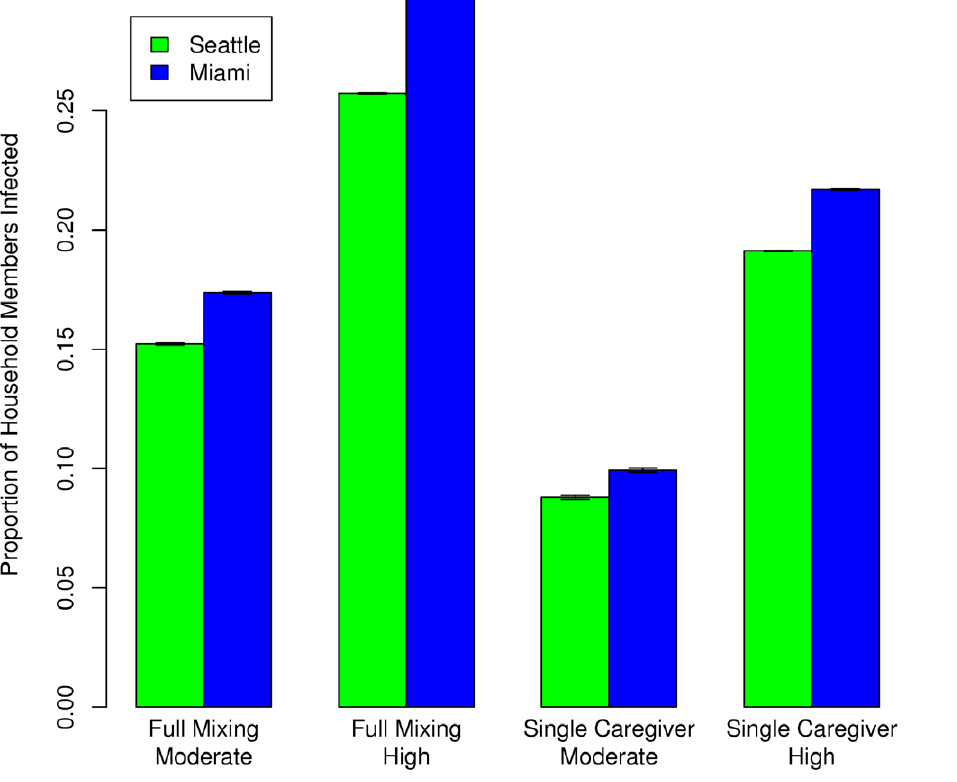
Figure 3. Proportion of household members infected (averaged over 100 runs and over all households) for Miami and Seattle. The x-axis shows the household structure and the overall attack rate (AR). This figure demonstrates that the single caregiver configuration indeed results in lower household transmission than the full mixing configuration. doi:10.1371/journal.pone.0022461.g003 PLoS ONE |